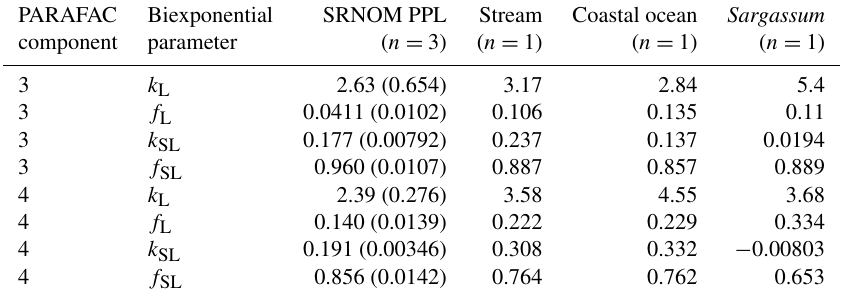
Table A2. Fitted biexponential model parameters (Eq. 3) for different DOM sources. f is unitless, and k is m 2 [molphotons] − 1 . Where n> 1, means are shown with standard deviations in parentheses. SRNOM PPL trials are three experiments using the same sample source, small wetland trials include three trials with the same sample source (to test non-SRNOM system stability) and two trials with samples from other dates, and large wetland trials include one trial each from three sampling dates. p values of biexponential model fits are all below 1 × 10 − 6 , except for k SL for Sargassum ( p = 0 . 016). Model parameters for every individual trial can be found in the associated data set (Armstrong, 2020).